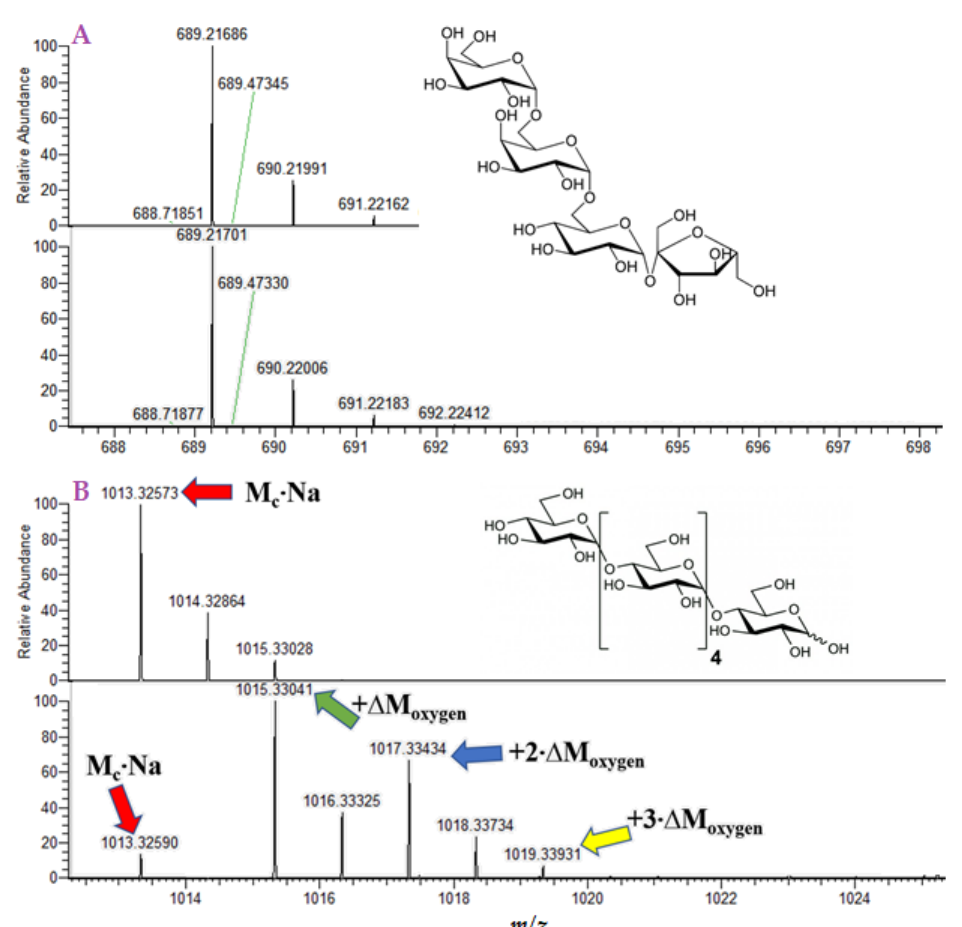
Figure 5. ( A ) Mass spectra of stachyose, before and after 16 O/ 18 O exchange. ( B ) Mass spectra of maltohexaose, before and after 16 O/ 18 O exchange.